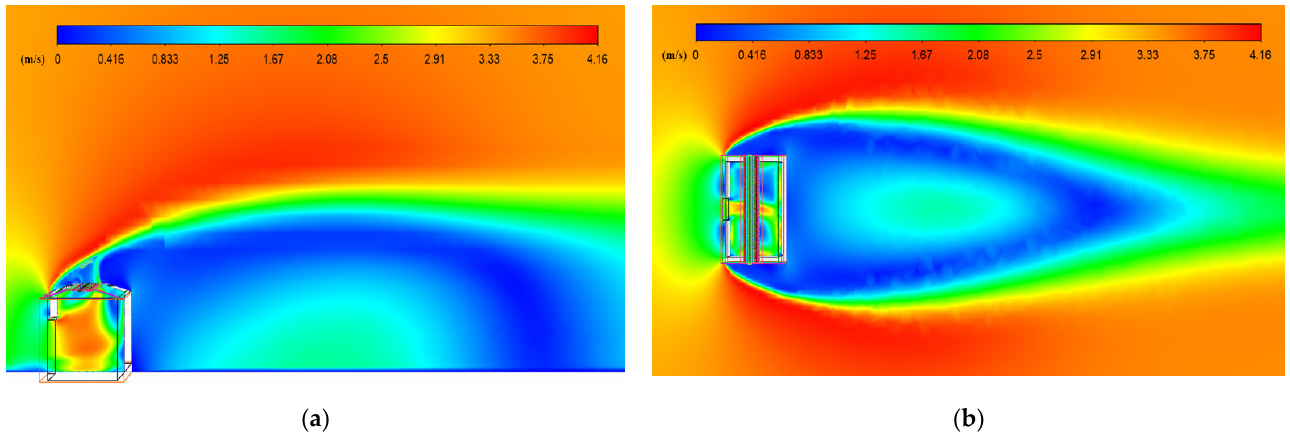
Figure 9. Velocity cloud diagram of the N33 scenario. ( a ) Side view; ( b ) plan view.